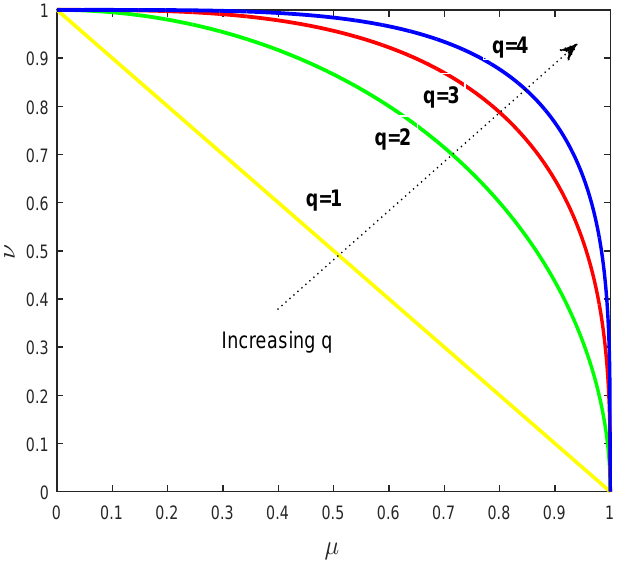
Figure 1. Spaces of acceptable q -rung Figure 2.1: Spaces of acceptable q -rung orthopairs